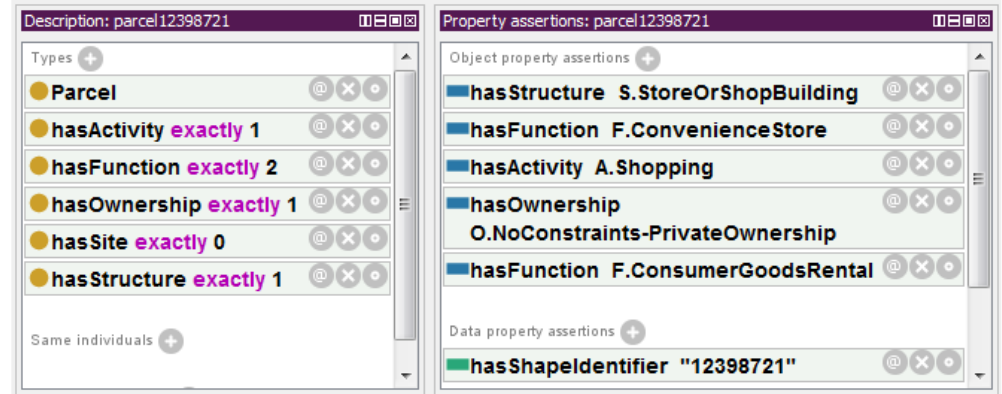
Figure 7. An individual representing one parcel in the map. The image shows how the world can be “closed” by asserting the cardinality of each